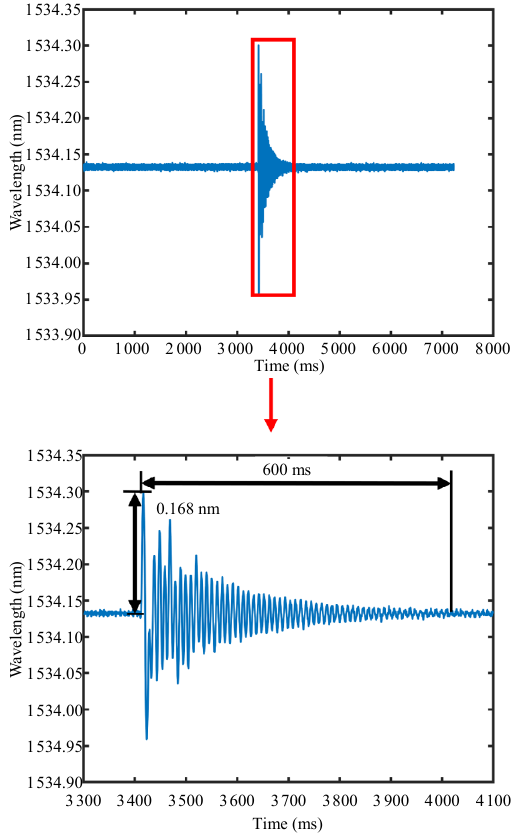
Fig. 12 Time-history curve of the wavelength without silicone